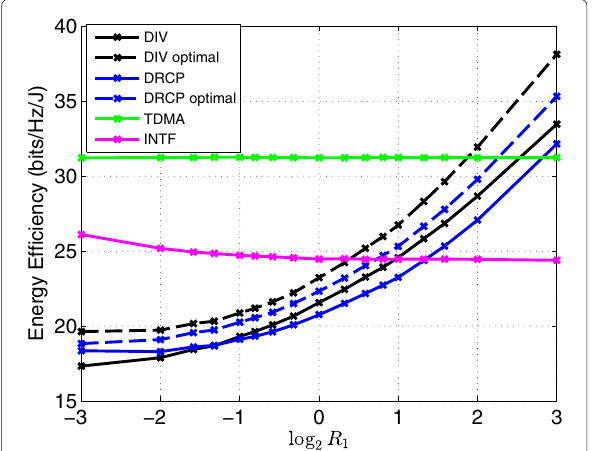
Fig. 6 Energy efficiency of the studied approaches in the circuit power-dominated regime with S min 1 = S min 1 = 0.3 bits/Hz